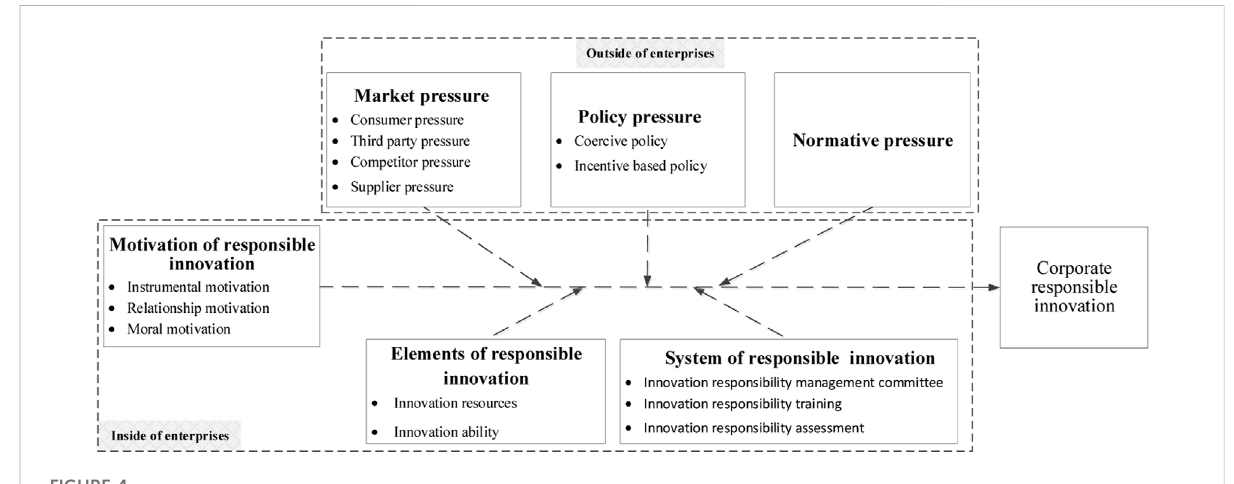
Drivers of corporate responsible